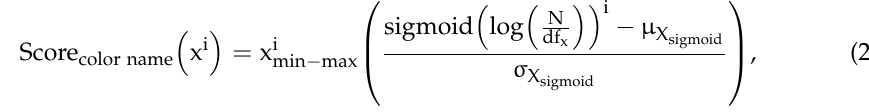
Figure 11. Colors with top 6 highest frequencies.